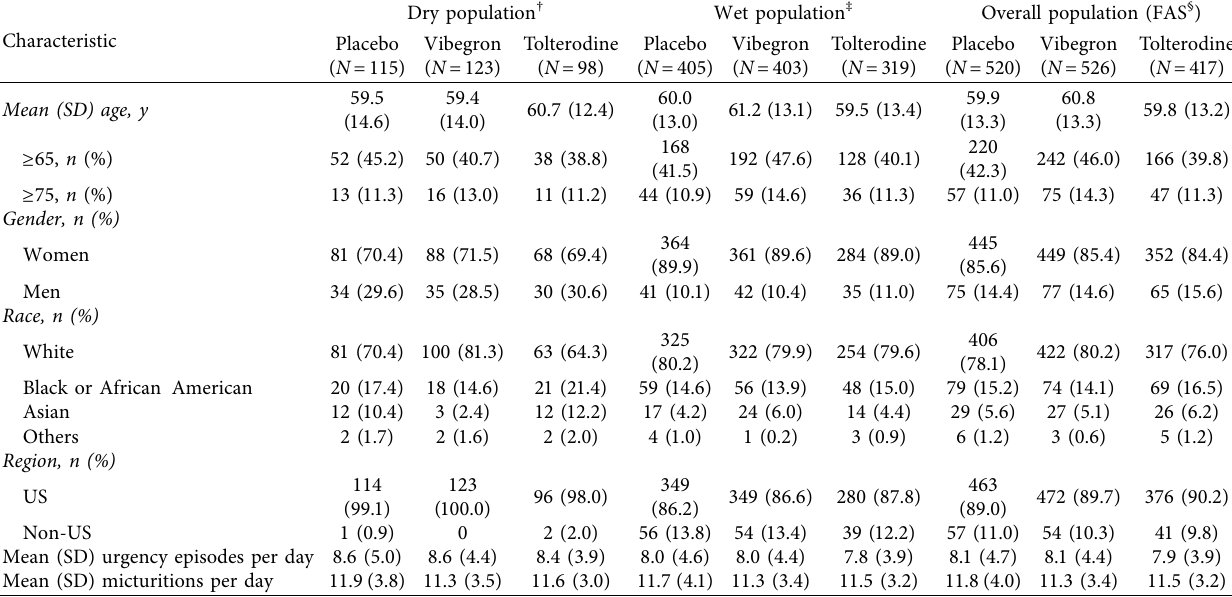
Table 1: Demographics and baseline clinical characteristics of patients with OAB dry and wet from the EMPOWUR trial.